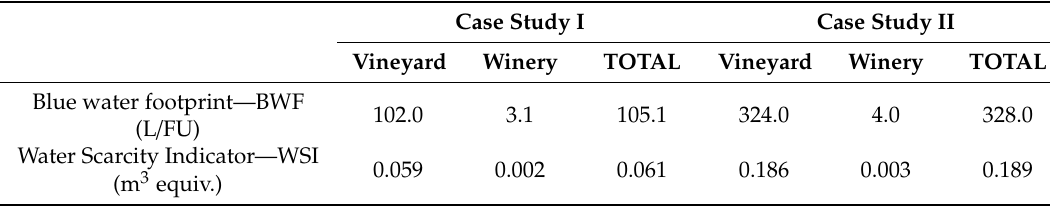
Table 5. Wine water footprint components for both case studies and 2018.